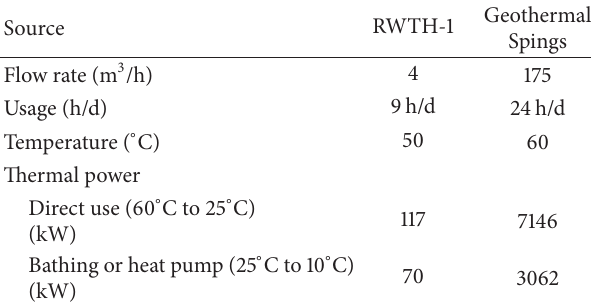
Table 1: Comparison thermal power of RWTH-1 BHE with